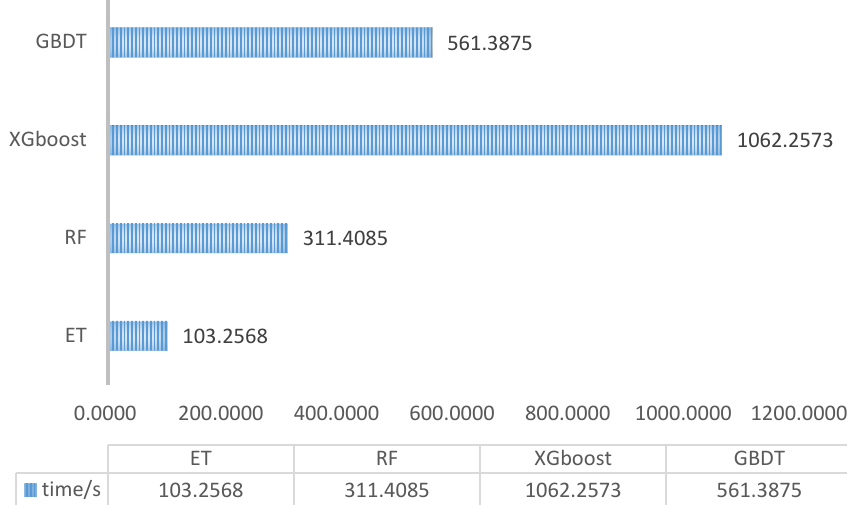
14 of 17 Figure 11. Decision tree number and classification accuracy.